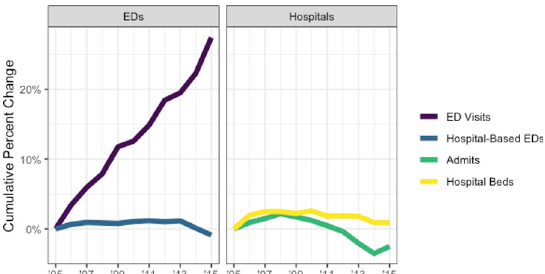
Fig 2. Nationwide percent change from 2005 baseline in ED and inpatient utilization. Source/Notes: Results are nationwide inventory of emergency department (ED) and inpatient availability and utilization from American